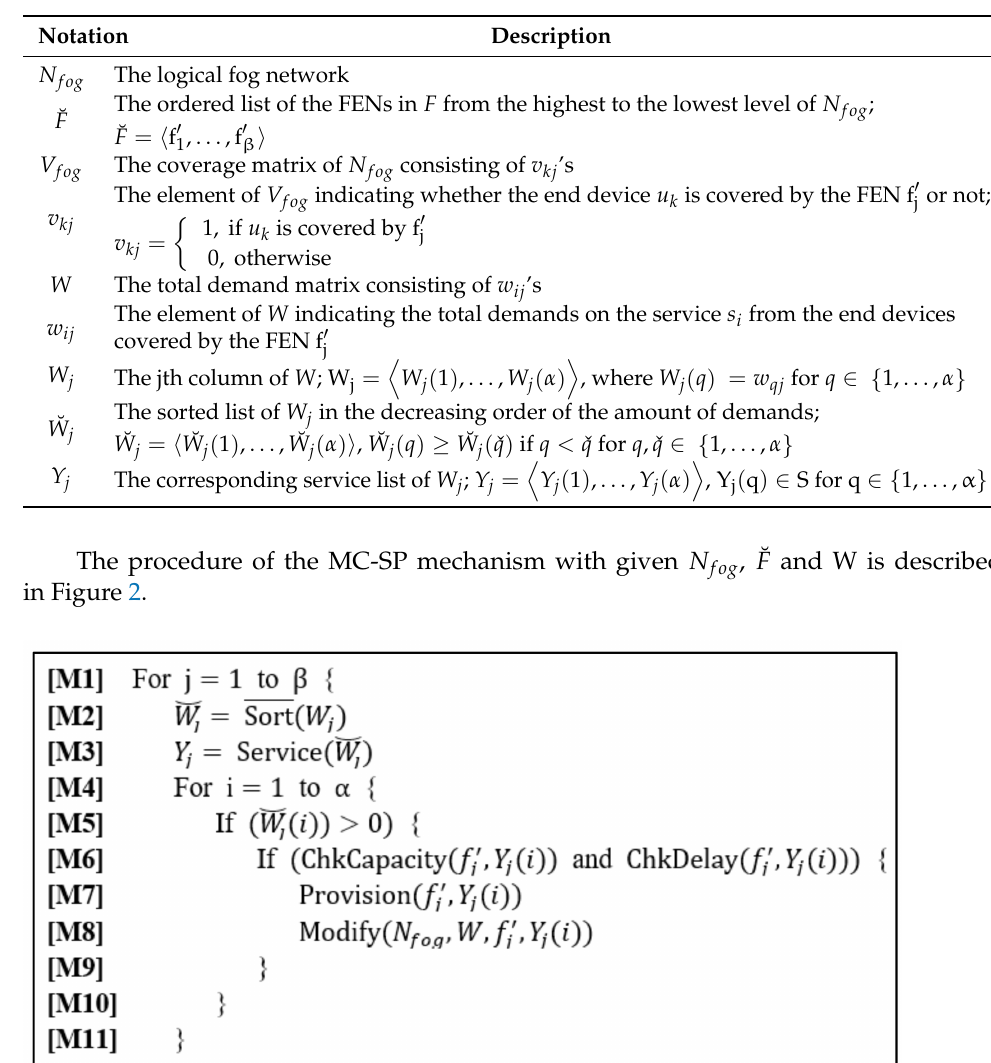
Table 2. Notations for the SP mechanisms.